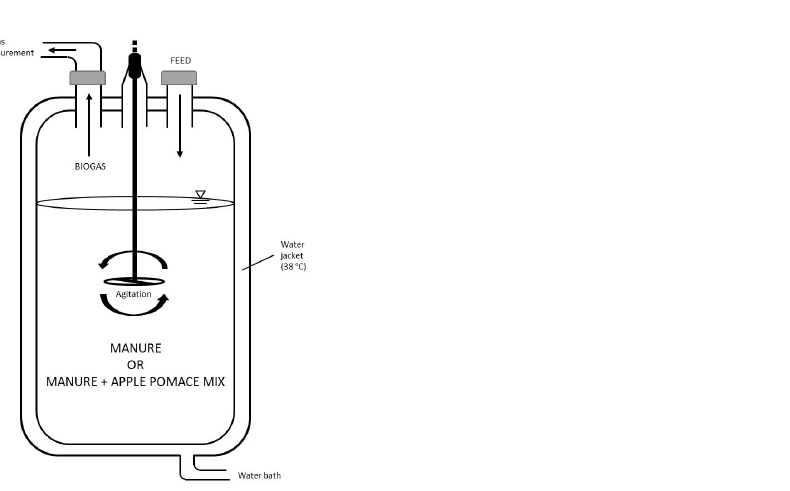
Figure 1. Experimental set-up of an anerobic reactor for the AD experiments. The arrows indicate the direction of the